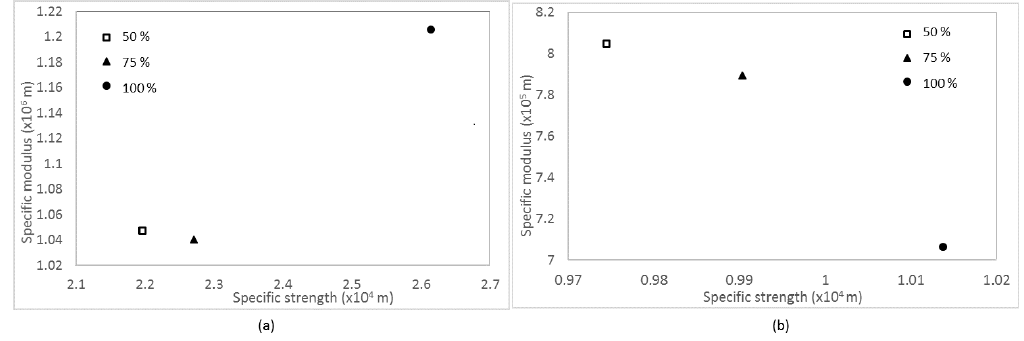
Figure 6. Effect of infill density on specific strength and modulus of ( a ) ABS/ZnO and ( b ) CABS/ZnO samples.